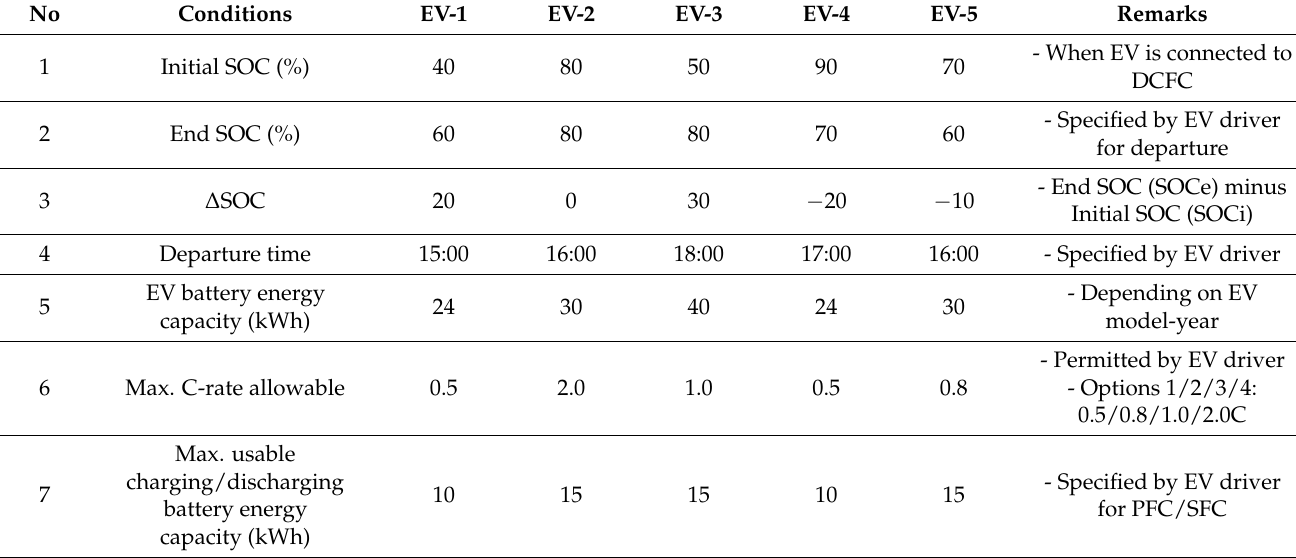
Table 1. Vehicle-to-building/grid (V2B/V2G) operational conditions and schedule of 5 electric vehicles (EVs) based on the preferences of EV